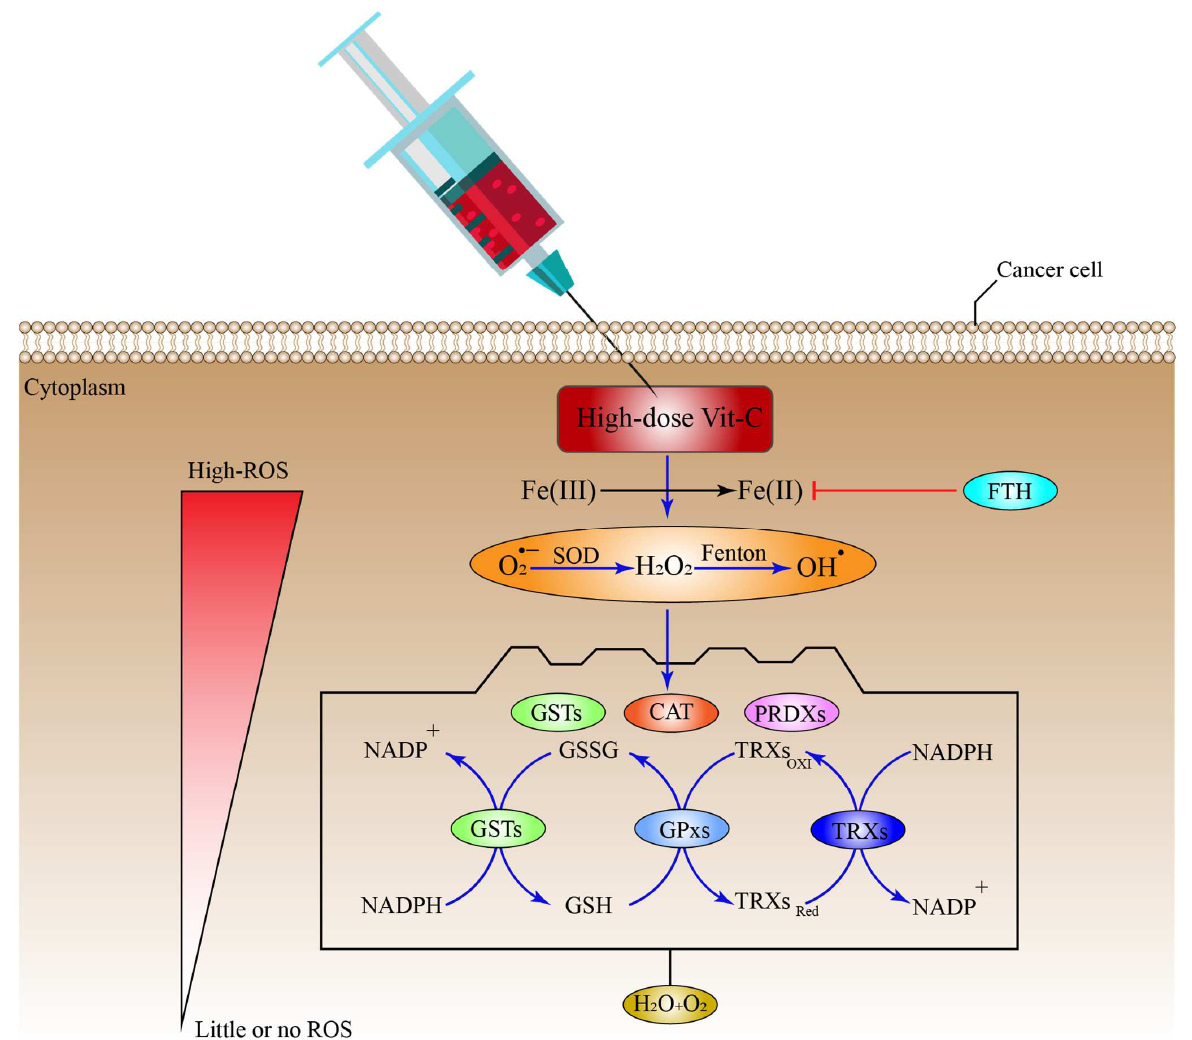
Figure 6. Inhibition of ROS generated by high-dose Vit-C via different antioxidant systems.